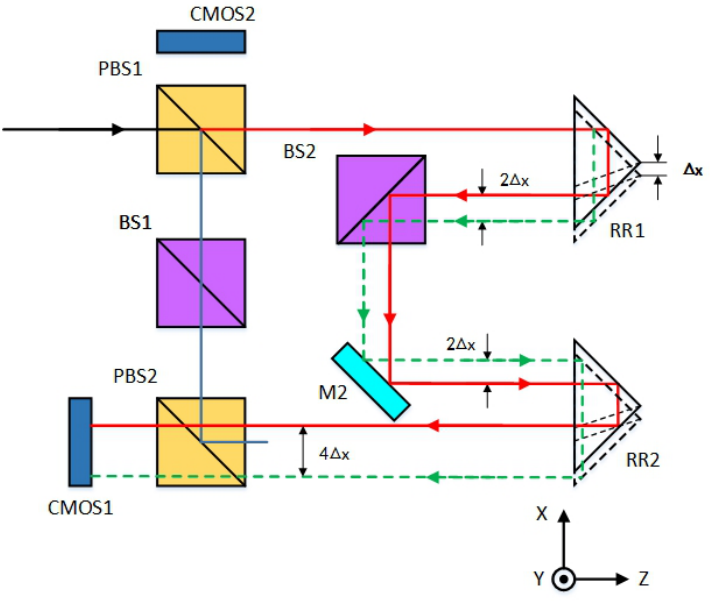
Figure 4. Measurement principle of horizontal straightness